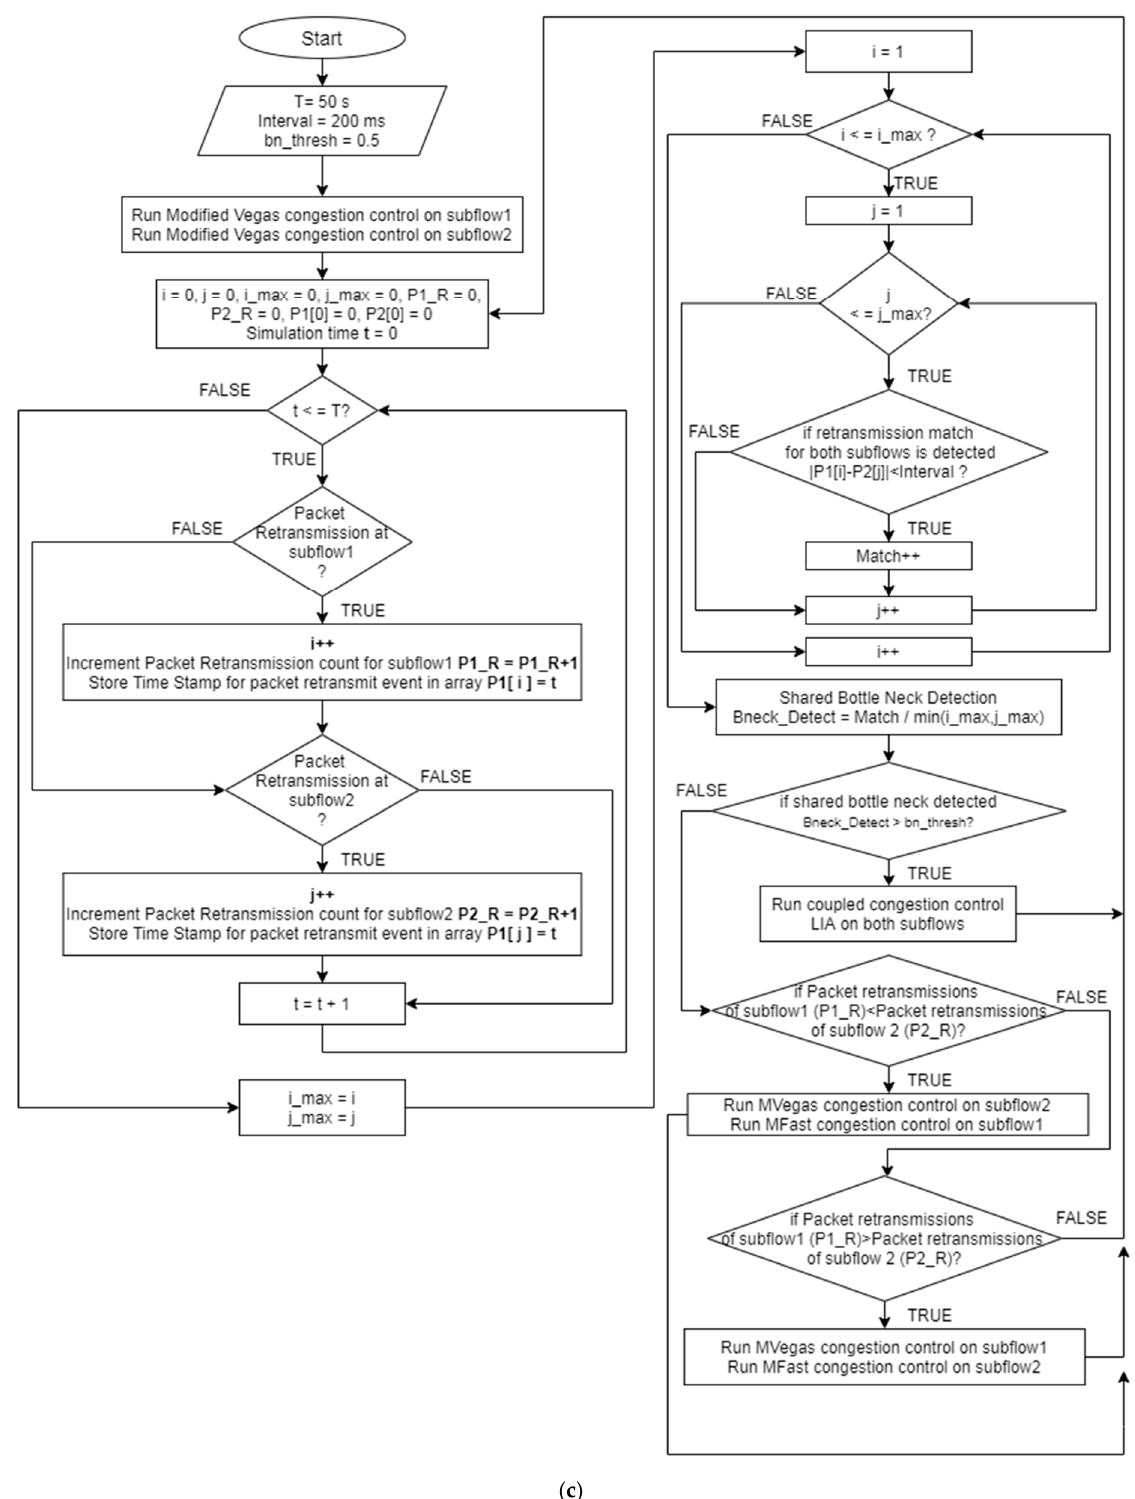
Figure 2. ( a ) IoT Protocol stack with proposed modified Fast-Vegas-LIA hybrid congestion control algorithm (MFVL HCCA) for multipath transmission control protocol (MPTCP); ( b ) System architecture; ( c ) Proposed MFVL HCCA flowchart.